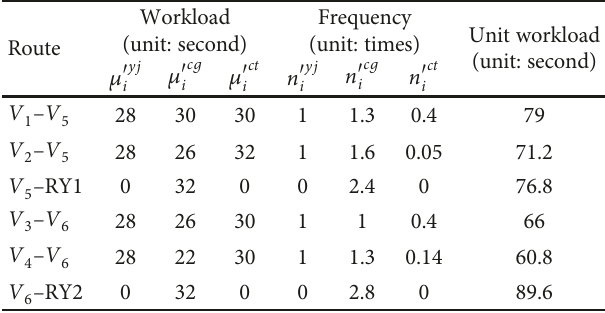
Table 4: Workload statistics of the sector 01.